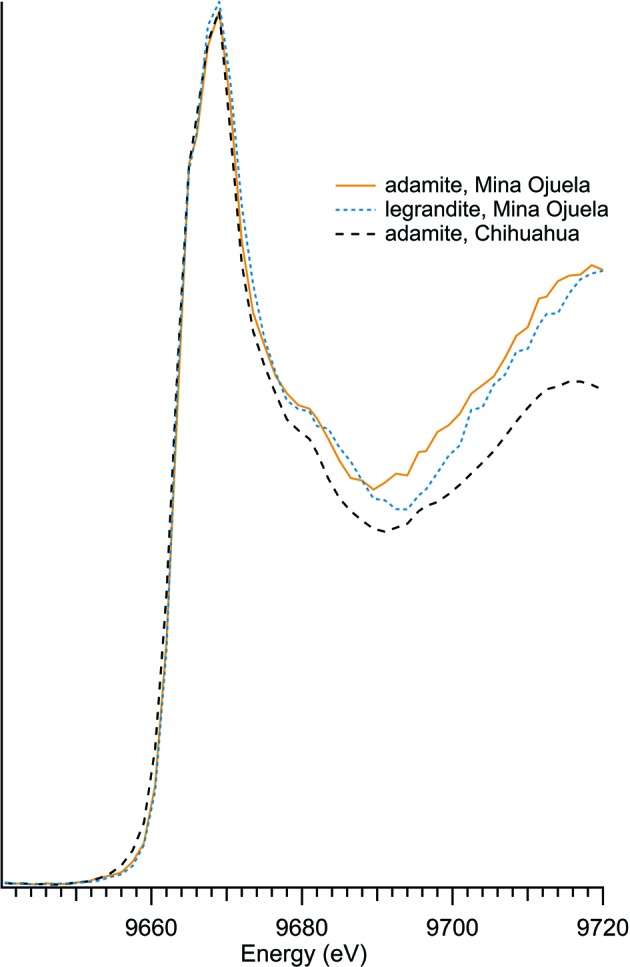
Zinc arsenate spectra.